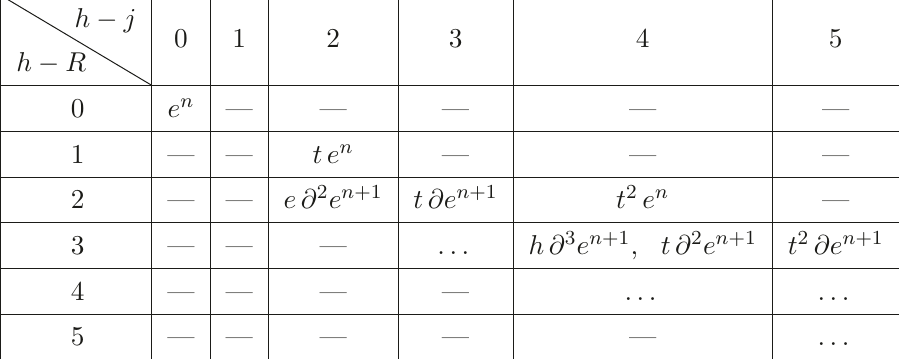
Table 4 . This table summarizes operators in the VOA V − 4 “twists” h j and h R . The label n runs over 0 , 1 , 2 , . . . , − − Only operators that are both quasi-primaries and sl (2) F highest weight states are displayed. The symbol “-” indicates that no operators exist with the given twists and “. . . ” indicate additional operators with dimension h > 6. The form of the operators is schematic but